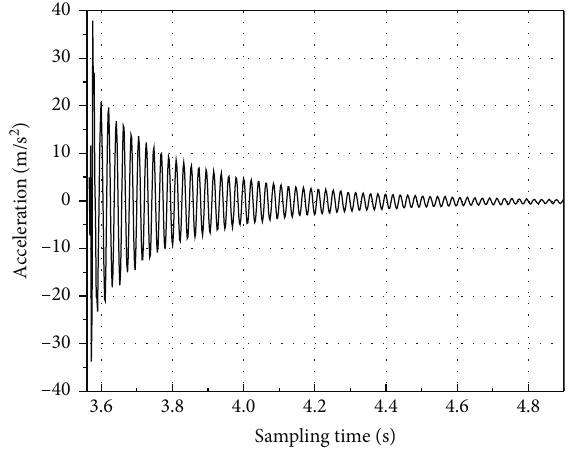
Figure 9: Acceleration-time curve of the concrete beam. Table 5: Damping ratio of the concrete beam at each damage stage.